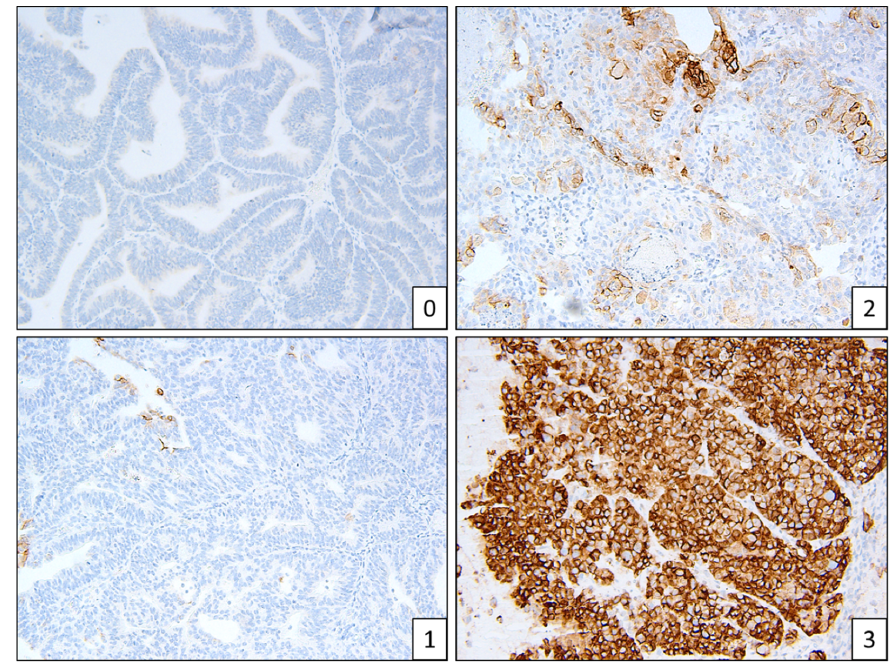
Figure 4. Example of L1CAM staining patterns, scores 0–3.